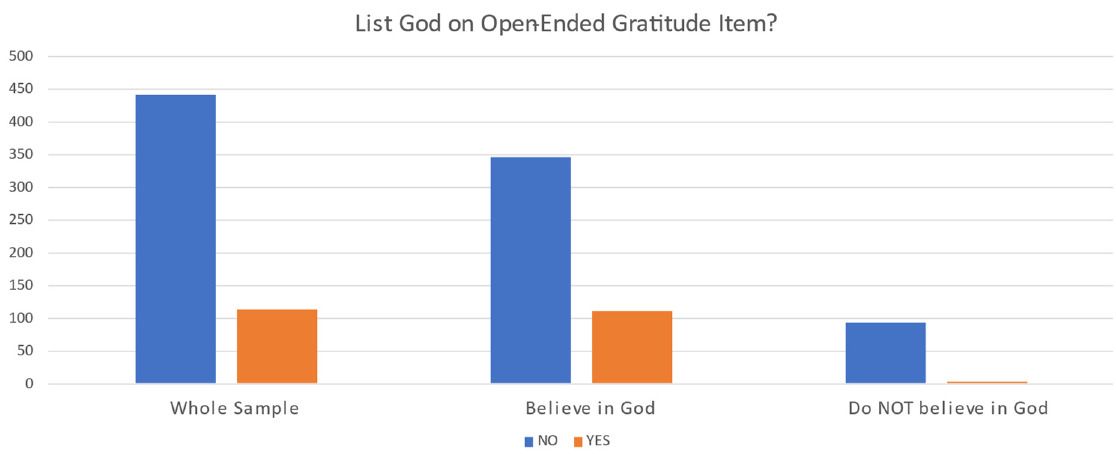
Figure 1. Open-Ended Gratitude Item: Number of Participants Who Listed God.